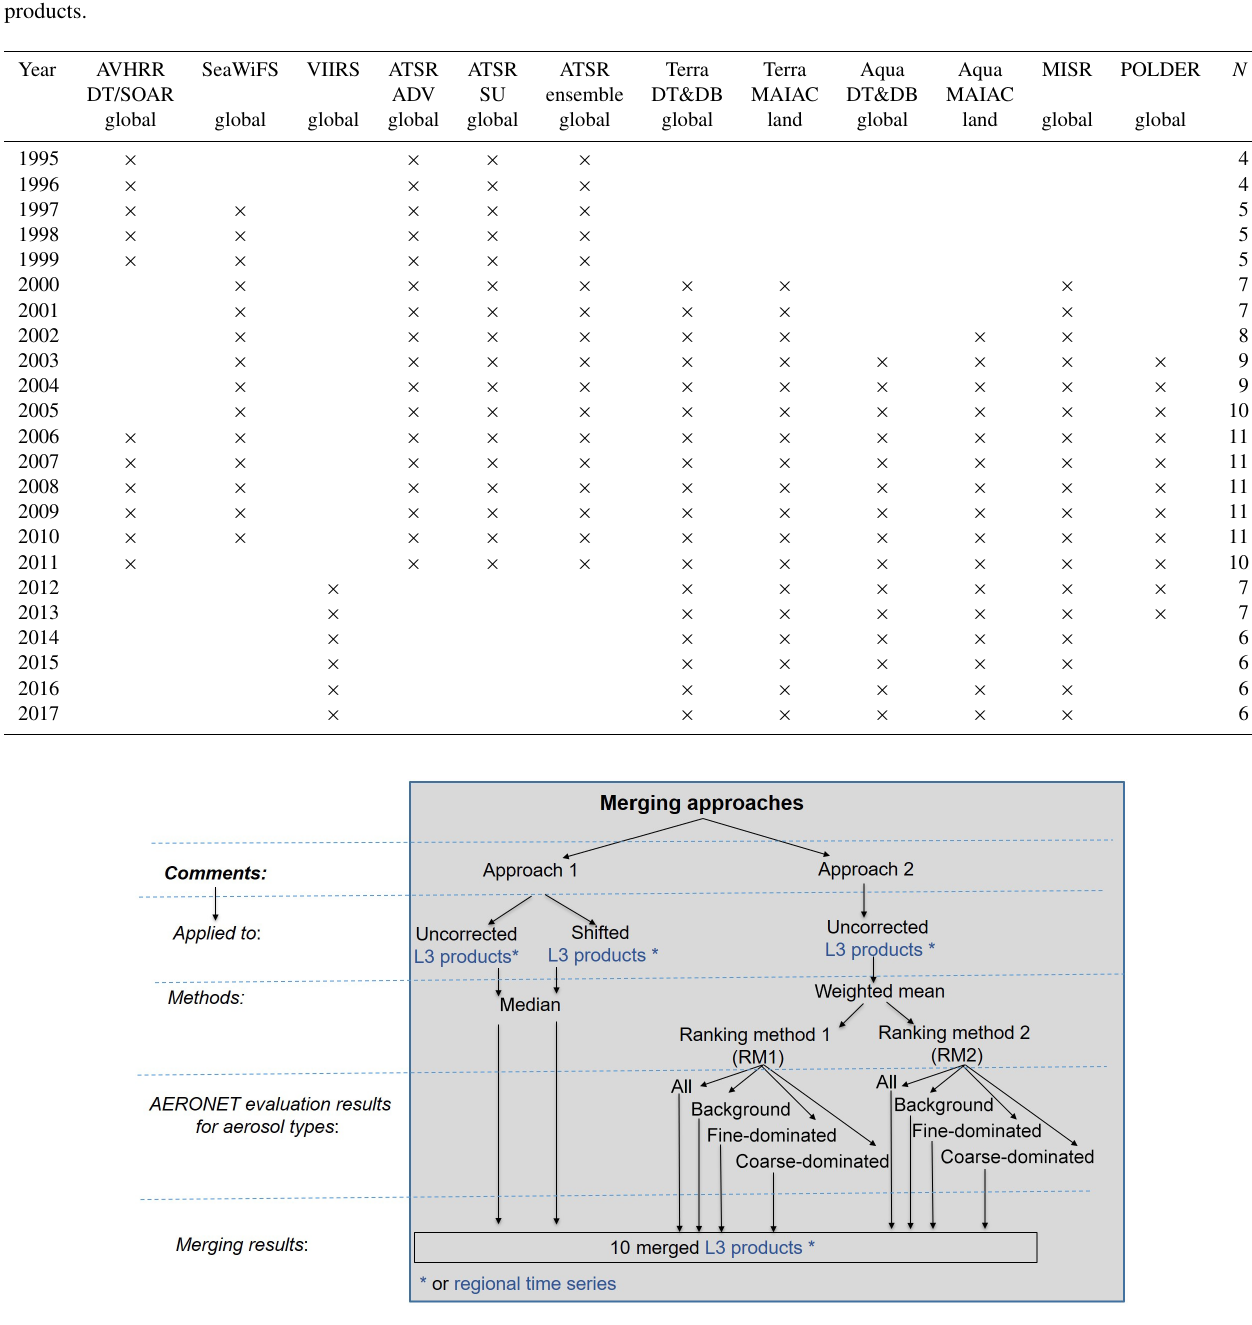
the weights are assigned based on the agreement of each dataset with monthly AERONET averages. This represents an initial attempt to adjust the level of confidence assigned to each product on a regional basis; better-comparing prod- ucts are given more weight in the calculation of a combined